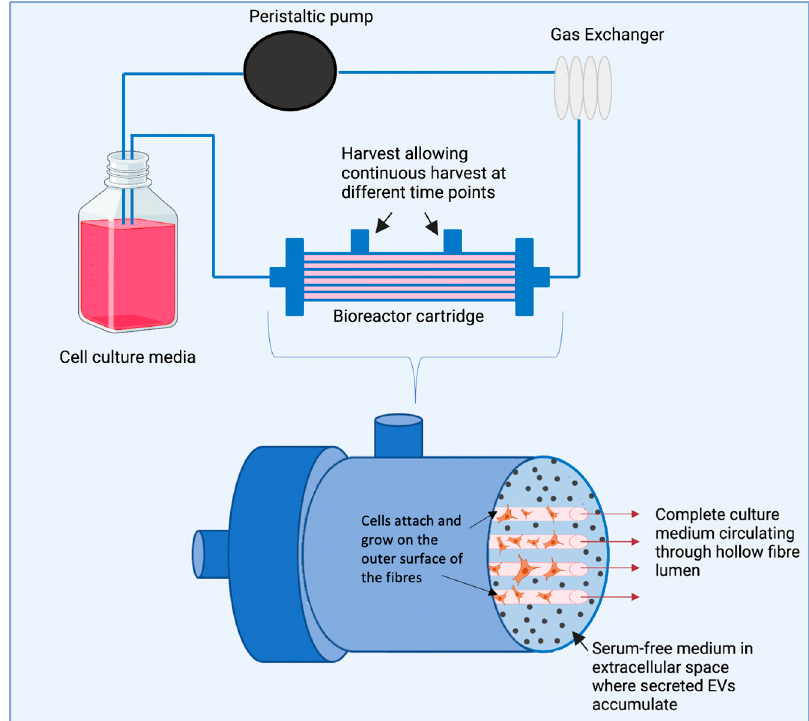
Figure 5. Schematic diagram of a hollow fibre bioreactor. Adapted with permission from I. K. Yan, N. Shukla, D. A. Borrelli and T. Patel, Methods in Molecular Biology; published by Springer Na- ture, 2018 [222].